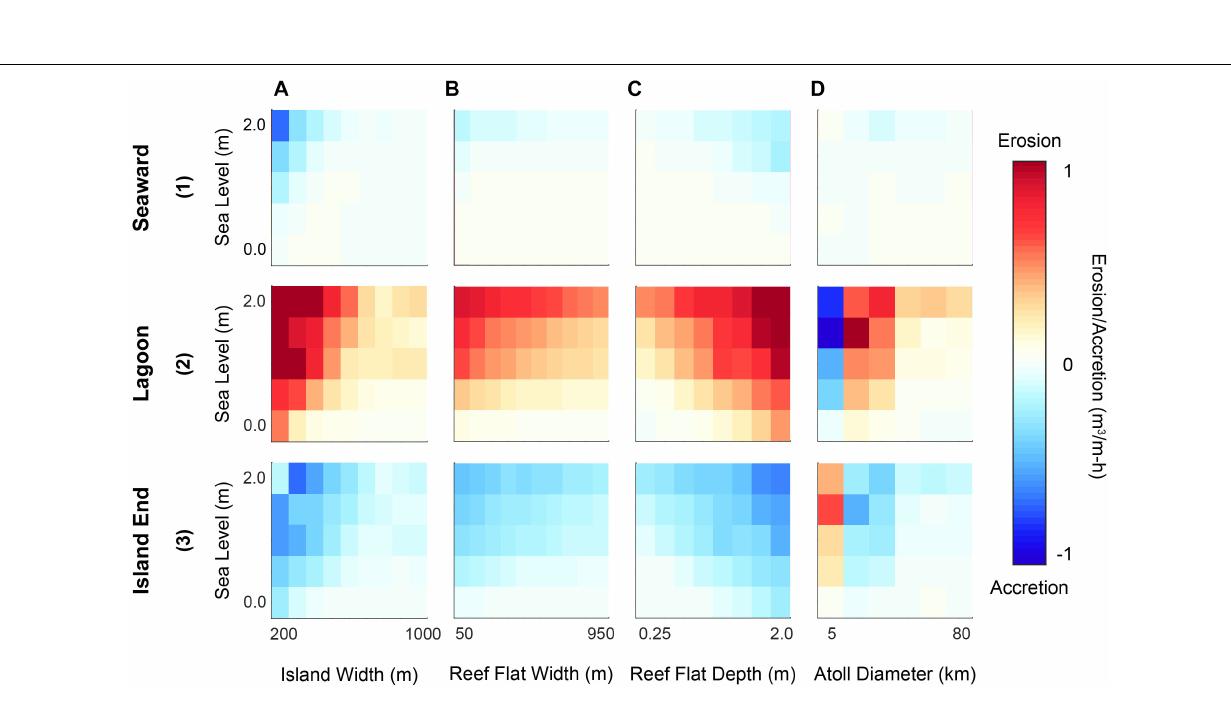
Frontiers in Marine Science |